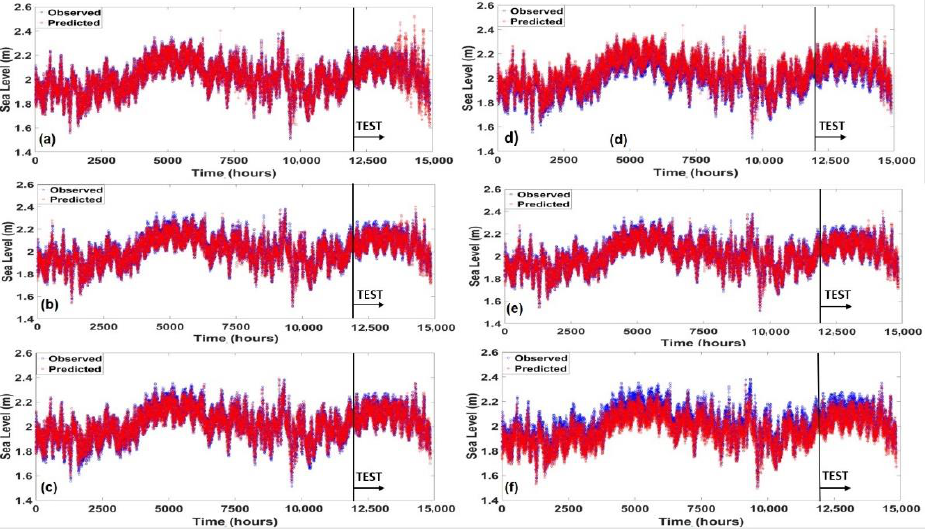
Figure 8. Multiple linear regression predictions: ( a ) SC1 -based 1 h ahead; ( b ) SC1 -based 12 h ahead; ( c ) SC1 -based 24 h ahead; ( d ) SC2 -based 1 h ahead; ( e ) SC2 -based 12 h ahead; ( f ) SC2 -based 24 h ahead.